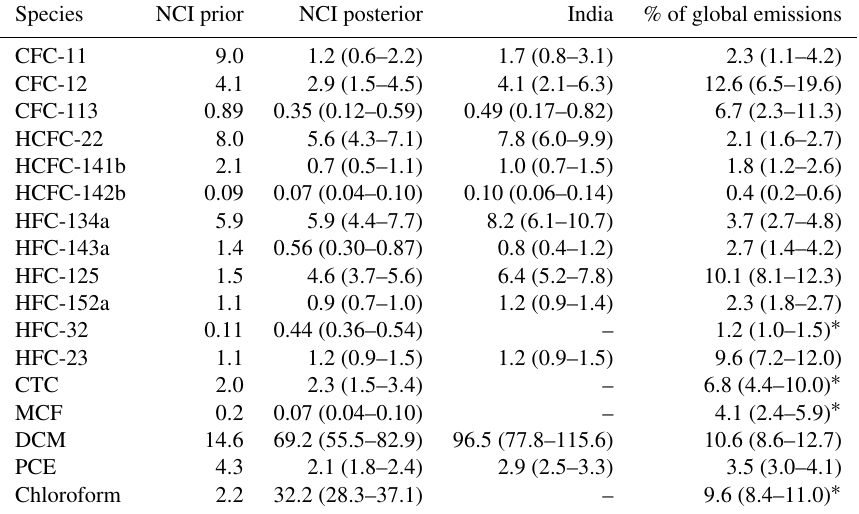
Table 4. Posterior mean halocarbon emission estimates reported (Ggyr − 1 ) for northern–central India and the whole of India, and the per- centage contribution of India to global emissions, where appropriate. The 5th and 95th percentile ranges are shown in parentheses. Asterisks denote that percentages are derived from the NCI total, as scaling to a national total was not considered appropriate for these gases.